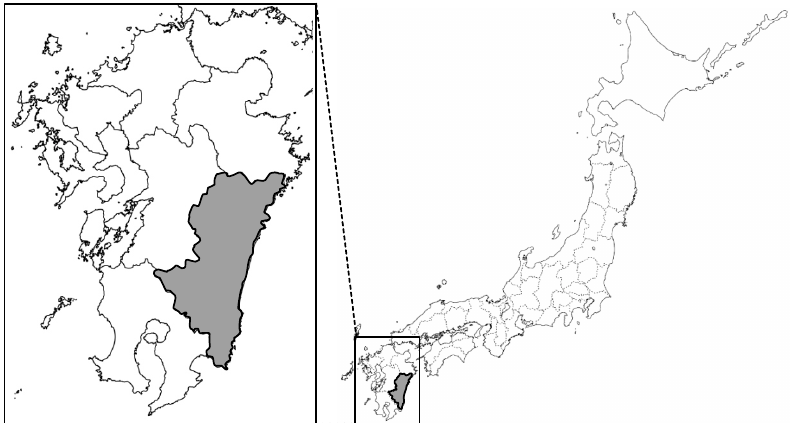
Figure 1. Map of Japan showing Miyazaki prefecture. The map indicates Miyazaki prefecture, where the sero-epidemiological survey was performed.